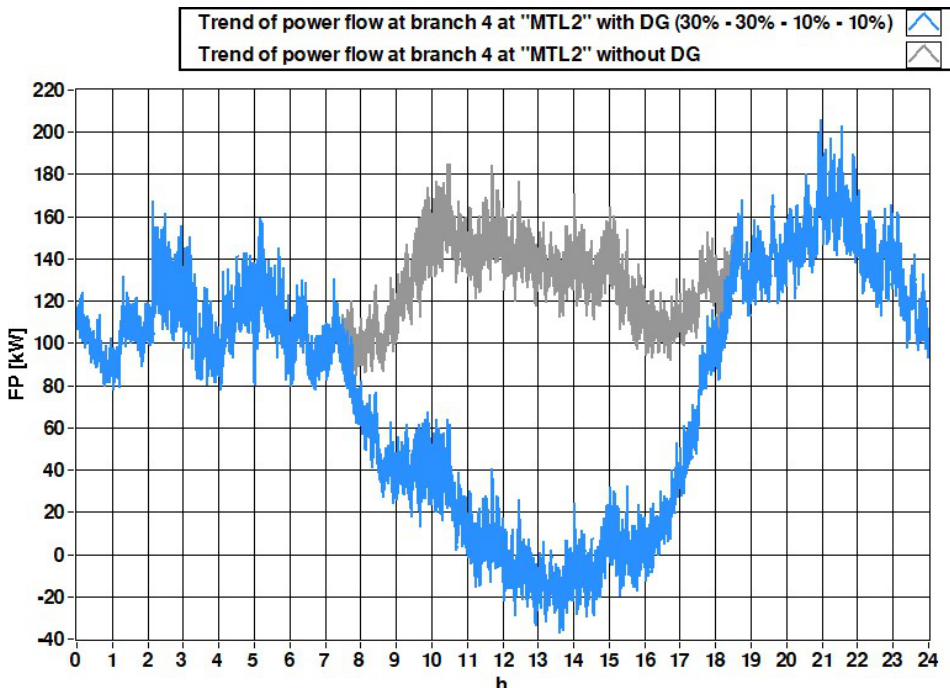
Figure 28. Active power flow during the day 31 May 2018 in branch 4 of the “MTL2” line, both in the absence and with the DG power injection corresponding to Scenario 4.